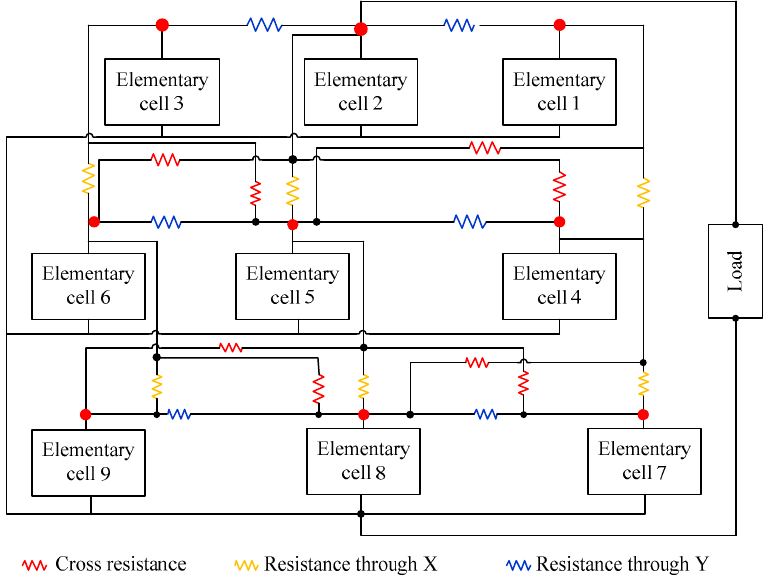
Figure 5. Simulink representation of 3D model PEMFC with nine elementary cells.